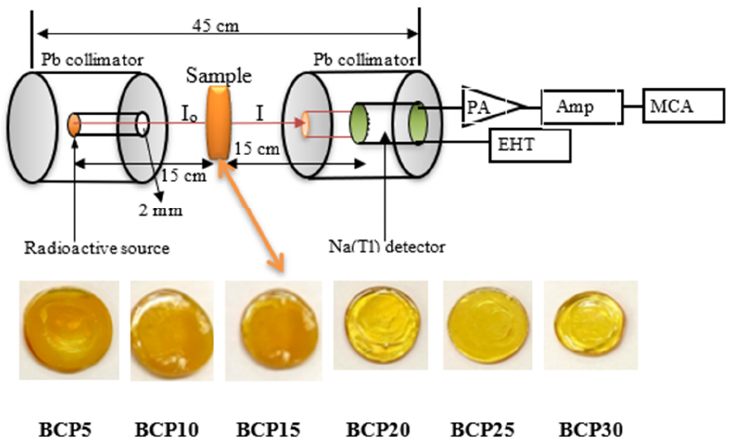
Figure 1. Experimental radiation measurements setup and fabricated samples of xBi 2 O 3 –(40 − x)CaO- 60P 2 O 5 glasses in mol%.